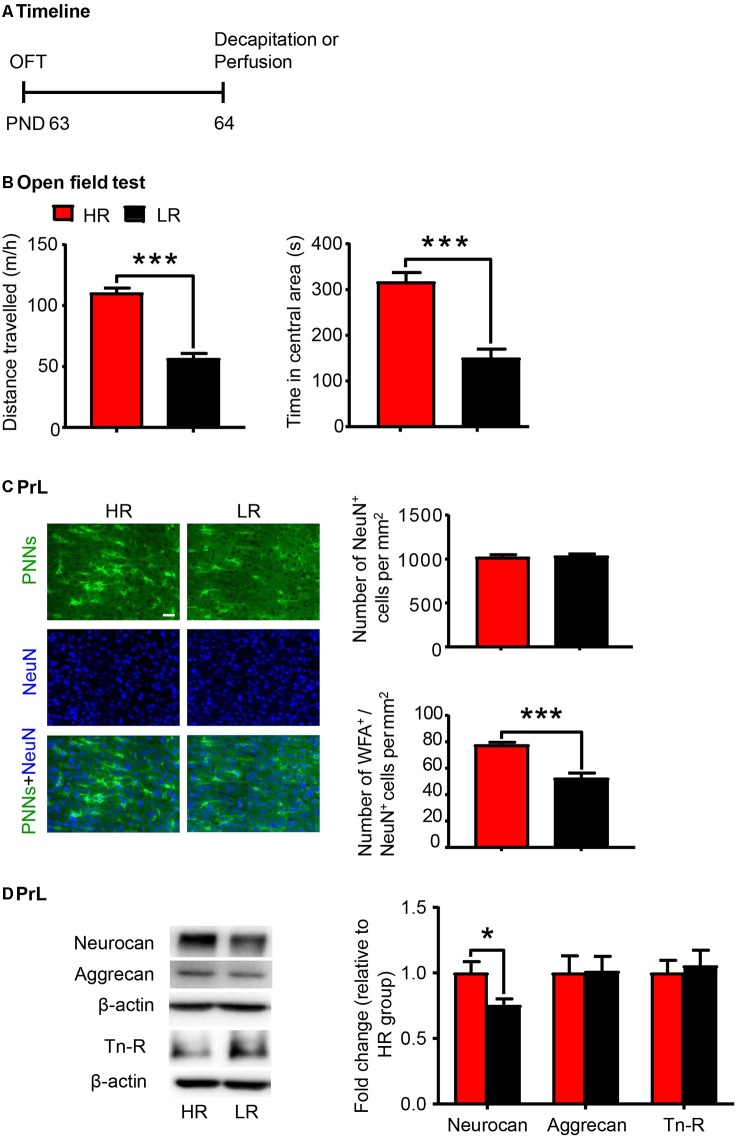
PNN density and component expression levels were associated with individual differences in locomotor response to novelty. (A) Timeline of the experimental procedure (n = 20 per group). (B) Total distance traveled and time spent in a central area in the open-field test (OFT). (C) Representative images of immunofluorescence staining of PNNs and quantification of NeuN+ and WFA+/NeuN+ cells in the PrL (n = 6 per group). Scale bar = 50 μm. (D) Representative western blots and quantification of fold changes in protein levels of PNNs components including neurocan, aggrecan and tenascin-R (Tn-R) in the PrL (n = 8 per group). The data are expressed as mean ± SEM. *p < 0.05, ***p < 0.001. HR, high responding phenotype; LR, low responding phenotype. PND, postnatal day.